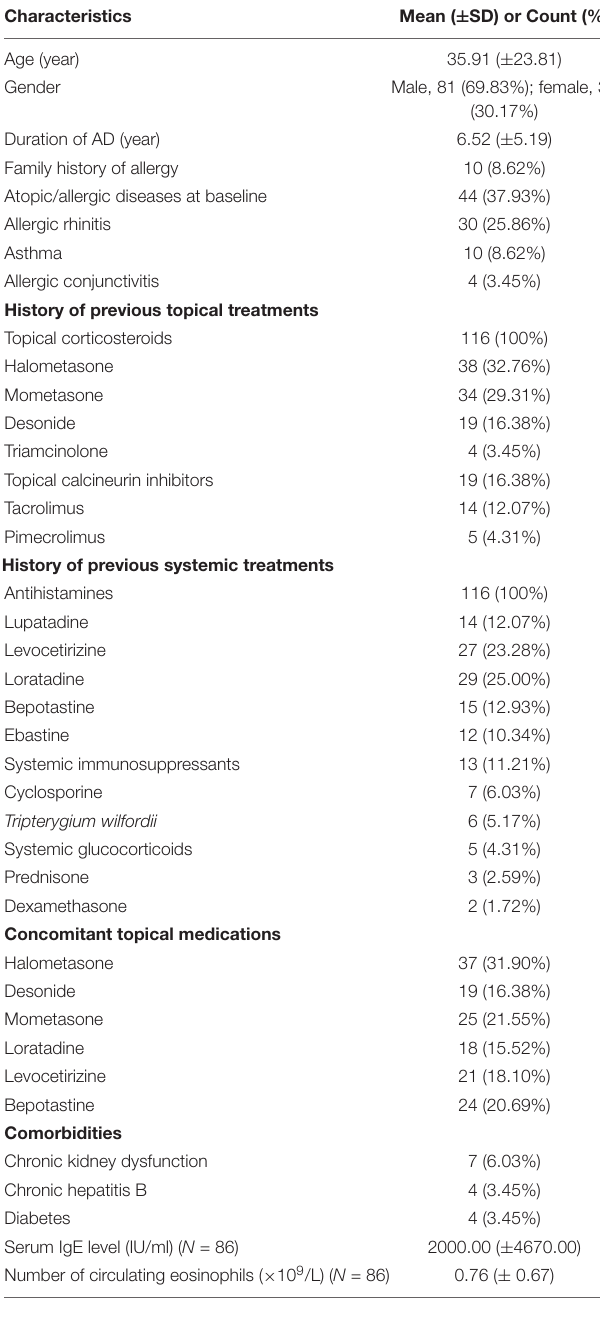
TABLE 1 | Baseline characteristics of AD patients included in this study ( N =